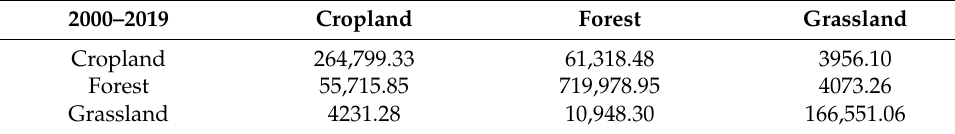
Figure 2. Changes in area of different LULC types: ( a ) cropland, ( b ) forest, ( c ) grassland. (Note: the black solid line represents the trend line, and the formula of cropland is y = − 0.707x + 1759.78; the formula of forest is y = 1.04x − 1294.51; the formula of grassland is y = − 0.64x + 1469.68). Table 1. Transformation matrix of land cover types from 2000 to 2019 (km 2